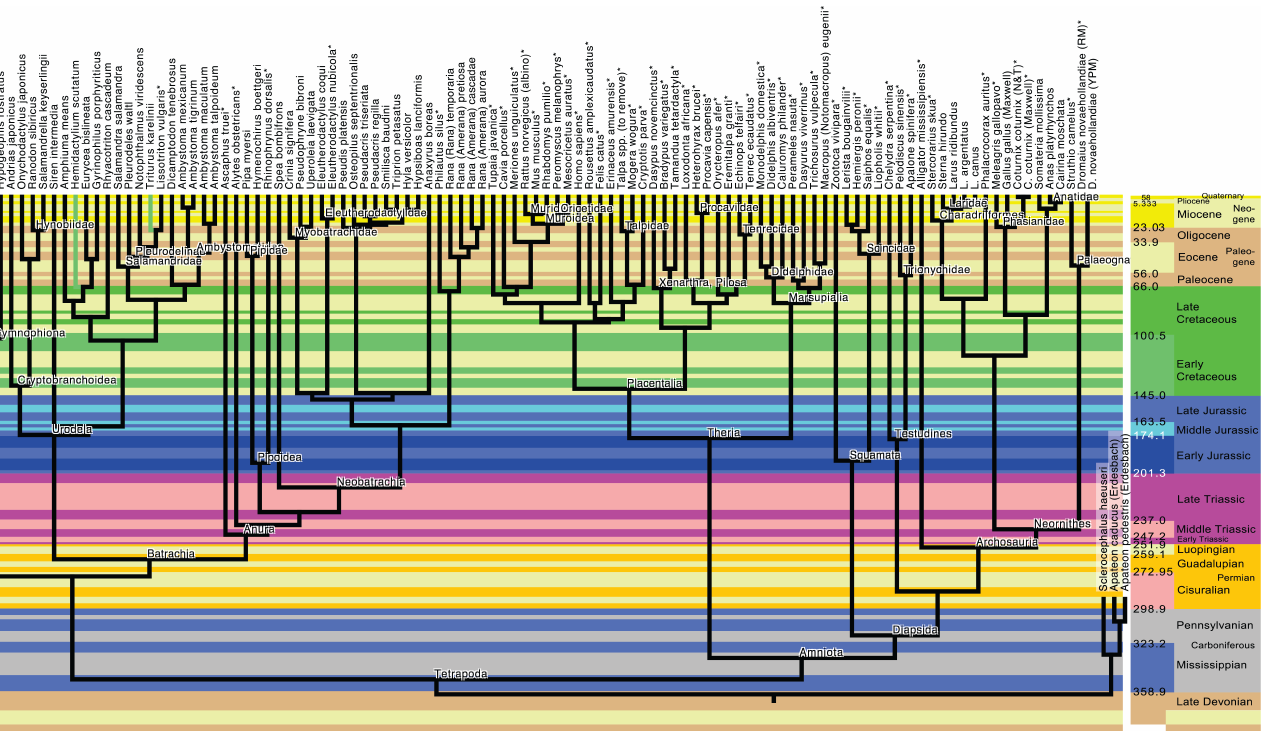
Figure 2 – Reference phylogeny used for some of the analyses, illustrating the LH (lep- ospondyl hypothesis) of lissamphibian origins. The tree was time-calibrated, but analy- ses showed that branch lengths are irrelevant, given that the best model is speciational (Tables 2–4). Main sources for topology and divergence times: Reeder (2003); Brandley et al. (2005); Pons et al. (2005); Lecompte et al. (2008); Bossuyt and Roelants (2009); Germain and Laurin (2009); Hugall et al. (2007); Gonzalez et al. (2009); Meredith et al. (2011); Sterli et al. (2013); Wang et al. (2013); Marjanović and Laurin (2014, 2019); Pyron (2014); Rabosky et al. (2014); Schoch (2014b); Prum et al. (2015); Zhuang et al. (2015); Tarver et al. (2016); Feng et al. (2017); Irisarri et al. (2017); Lu et al. (2017); Pardo et al. (2017a); Jetz and Pyron (2018). The colored bands represent geological stages from the international geological timescale (Ogg et al.,